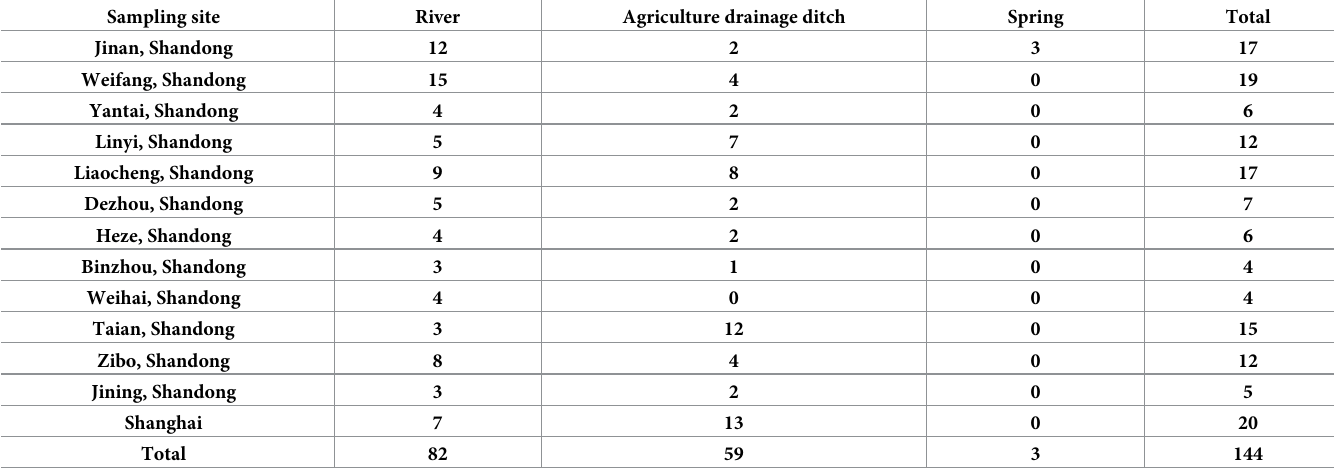
Table 1. Sample collection